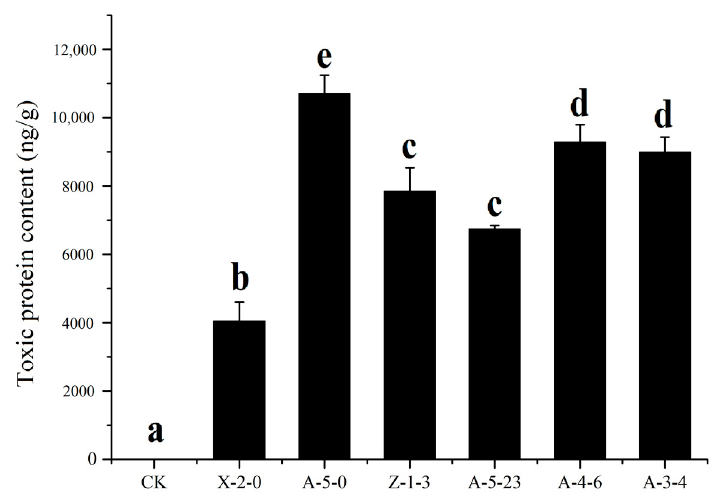
Figure 4. Analysis of toxin protein contents in Bacillus thuringiensis ( Bt ) transgenic poplar. According to Tukey’s Honestly Significant Difference Test, the letters indicate statistical significance per ANOVA ( p < 0.05) among different lines.